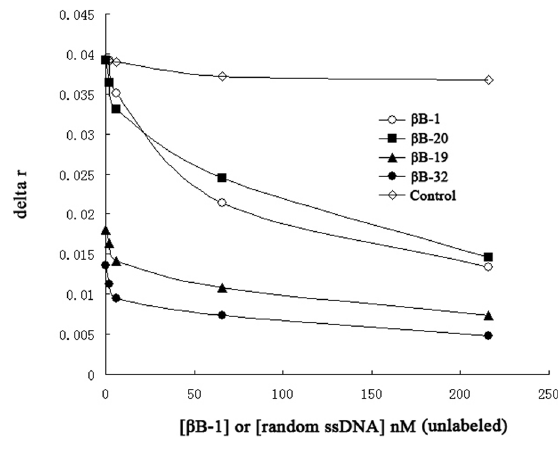
Figure 3. Determination of the binding sites of selected aptamers by competitive anisotropy assay. Two nM of fluores- cently labeled aptamer ( b B-1, b B-20, b B-19 or b B-32) was firstly incubated with 288 nM of b -BuTx, and then titrated with increasing concentrations of unlabeled aptamer b B-1. Labeled b B-1 was also titrated with unlabeled random ssDNA as control.